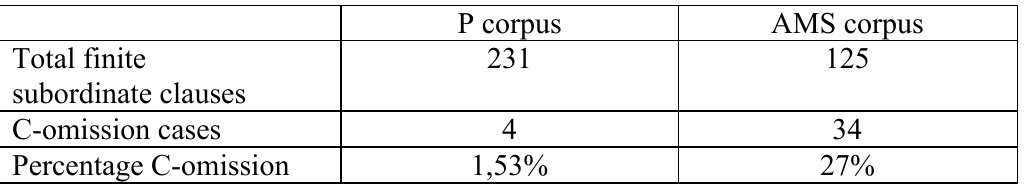
Table 2 . C-omission in various subordinate